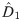
ABIDE data set: Distance contrast D^1 between the unweighted ASD and control connectomes for a threshold T = 0.5.